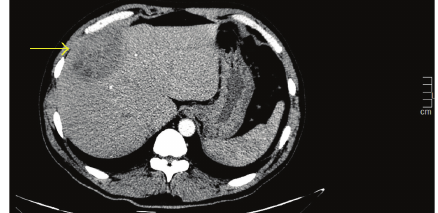
Figure 1: Whole abdominal triphasic CT scan showing an ill-defined, solid-cystic focus exhibiting peripheral enhancement in segment 8 of the liver measuring 7.5 × 6.8 × 6.1 cm.